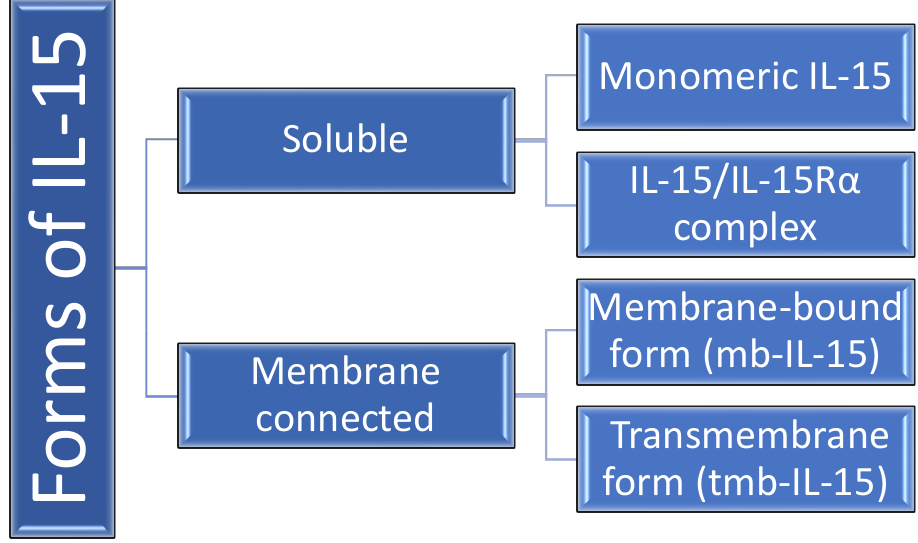
Figure 1. Forms of IL-15 in humans. IL-15Rα–IL-15 receptor α.